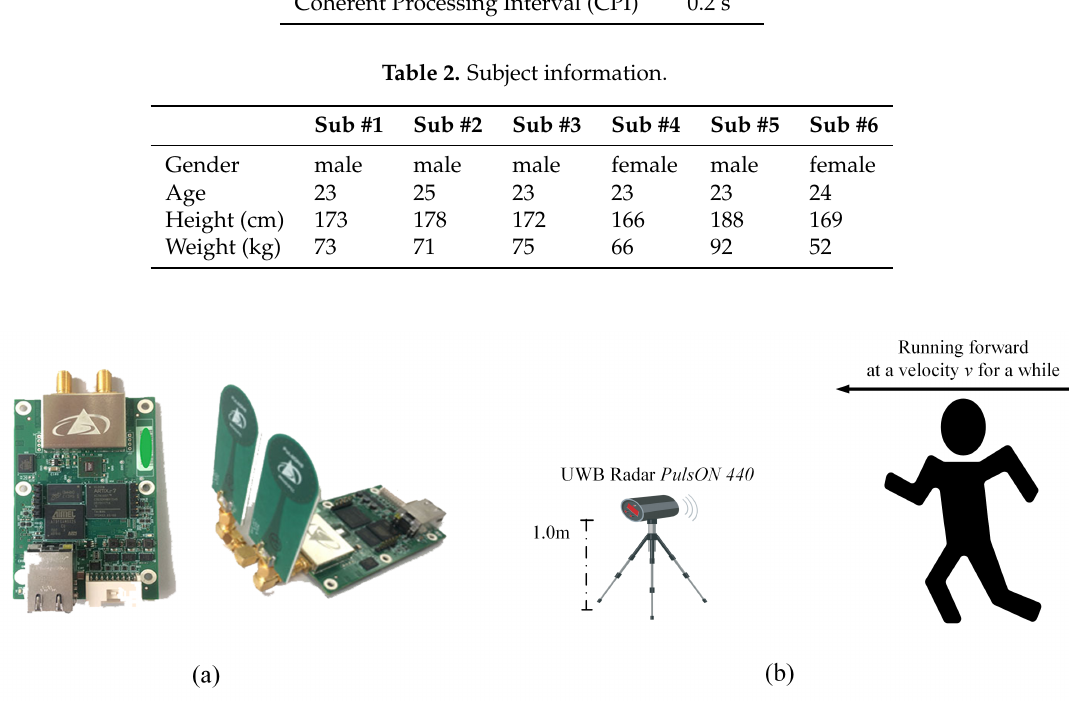
Figure 5. ( a ) Photo of UWB radar module named PulsON 440 ; and ( b ) experimental deployment diagram where a tested person is running towards the radar at a velocity v